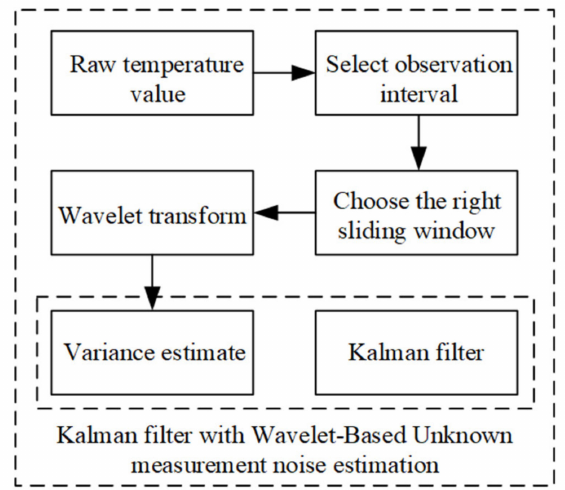
Figure 4. The flow diagram of the wavelet transform algorithm to solve the noise